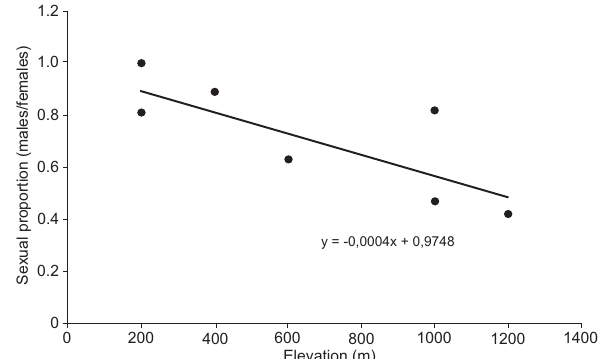
Figure 2. Sex ratio (males/females) of Pygoderma bilabiatum at dif- ferent elevations. We considered only samples with 10 or more